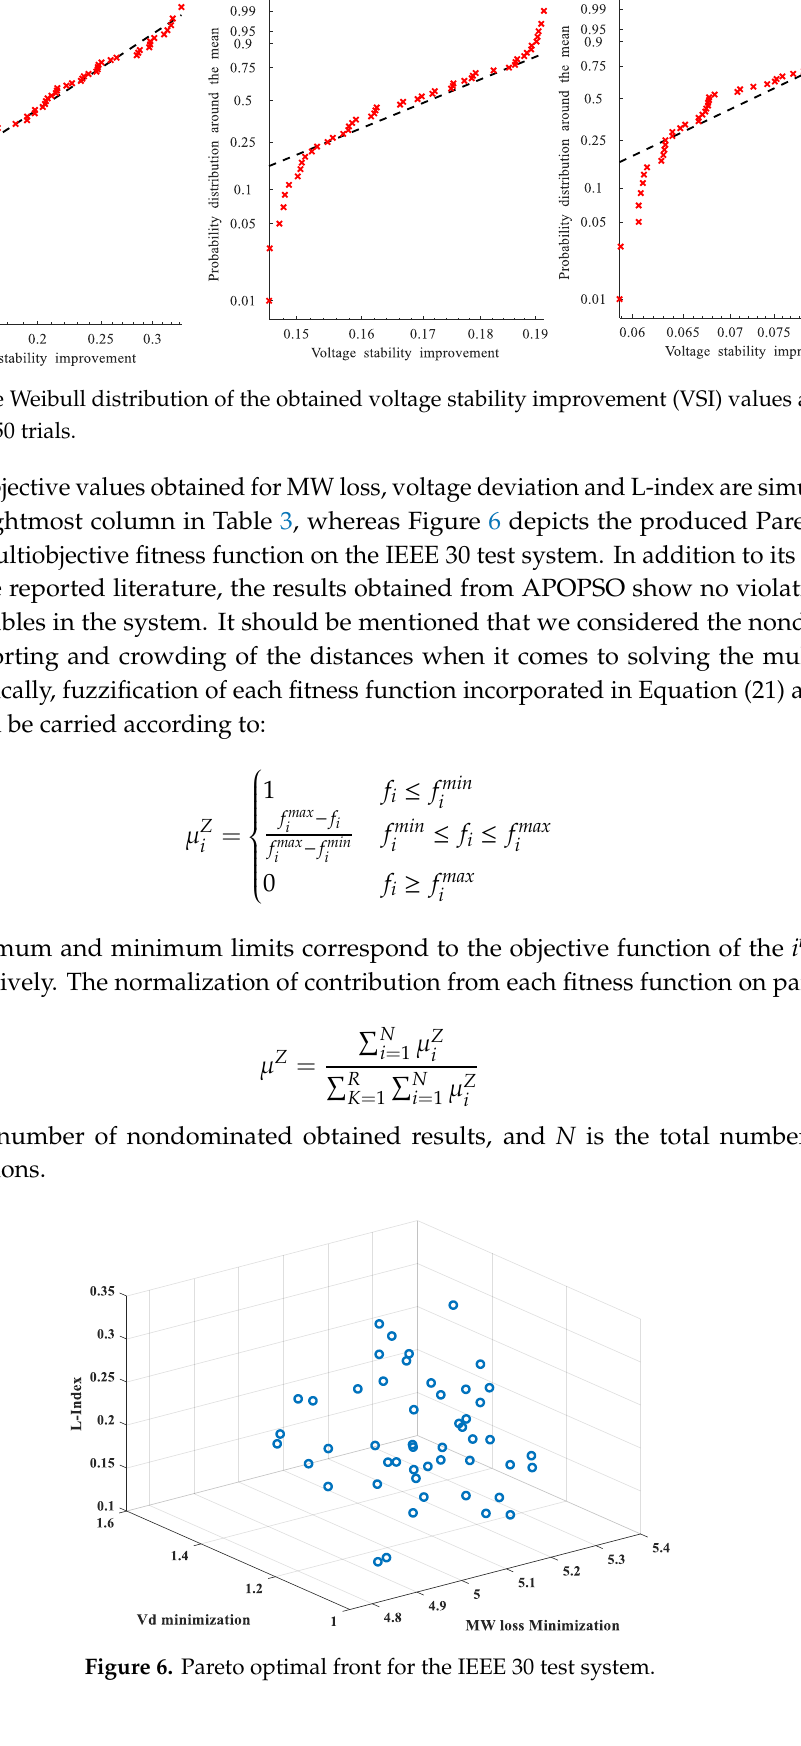
Table 4. Statistical analysis of the APOPSO algorithm for three test system.